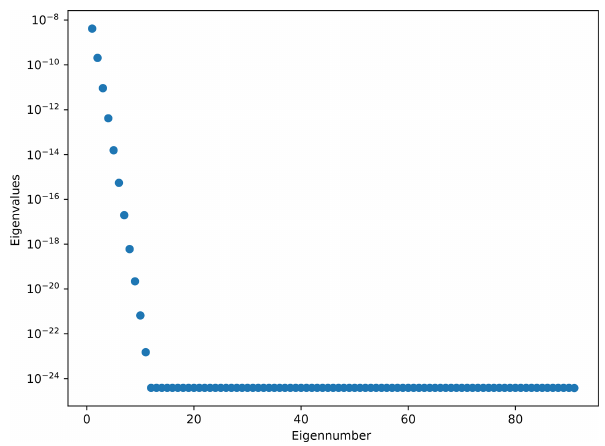
Figure 7. Eigenvalue of the S matrix plotted as function of the